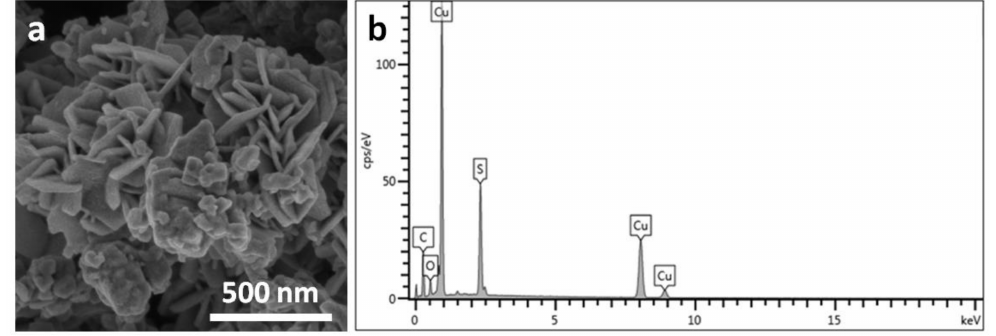
Figure 2. Scanning electron microscope (SEM) image ( a ) and corresponding energy-dispersive X-ray spectroscopy (EDS) analysis ( b ) of the sample after